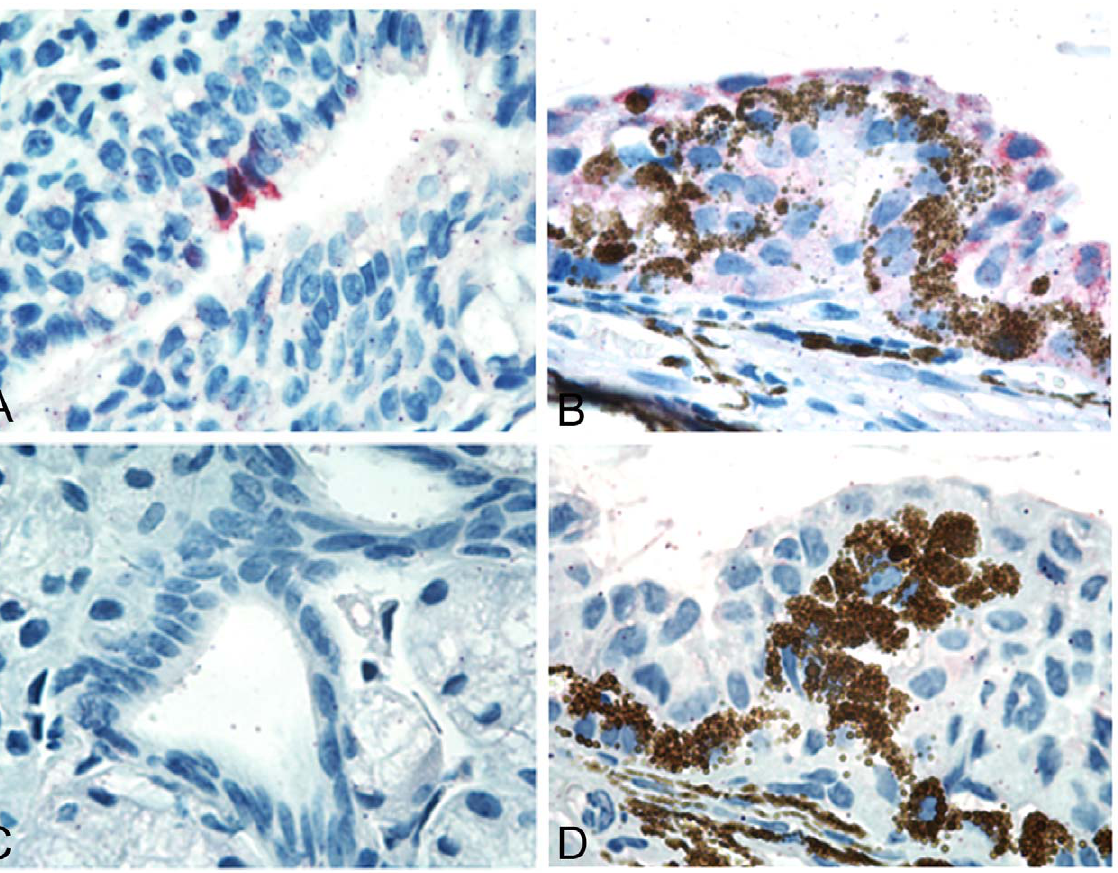
Figure 3. Photomicrographs of ferret tissue sections stained for the presence of influenza viral antigen following ocular inoculation. Ferrets were inoculated by the ocular route with 10 6 EID 50 /ml of NL/230 or Brisbane virus, and tissues were collected day 3 p.i. for analysis. Viral antigen (staining in red) found in epithelial cells of lacrimal glands in the conjunctiva of a ferret inoculated with Brisbane virus (A) and epithelial cells of the ciliary processes in the eye of a ferret infected with NL/230 virus (B). No virus staining was present in the conjunctiva (C) or eye (D) of control ferrets.